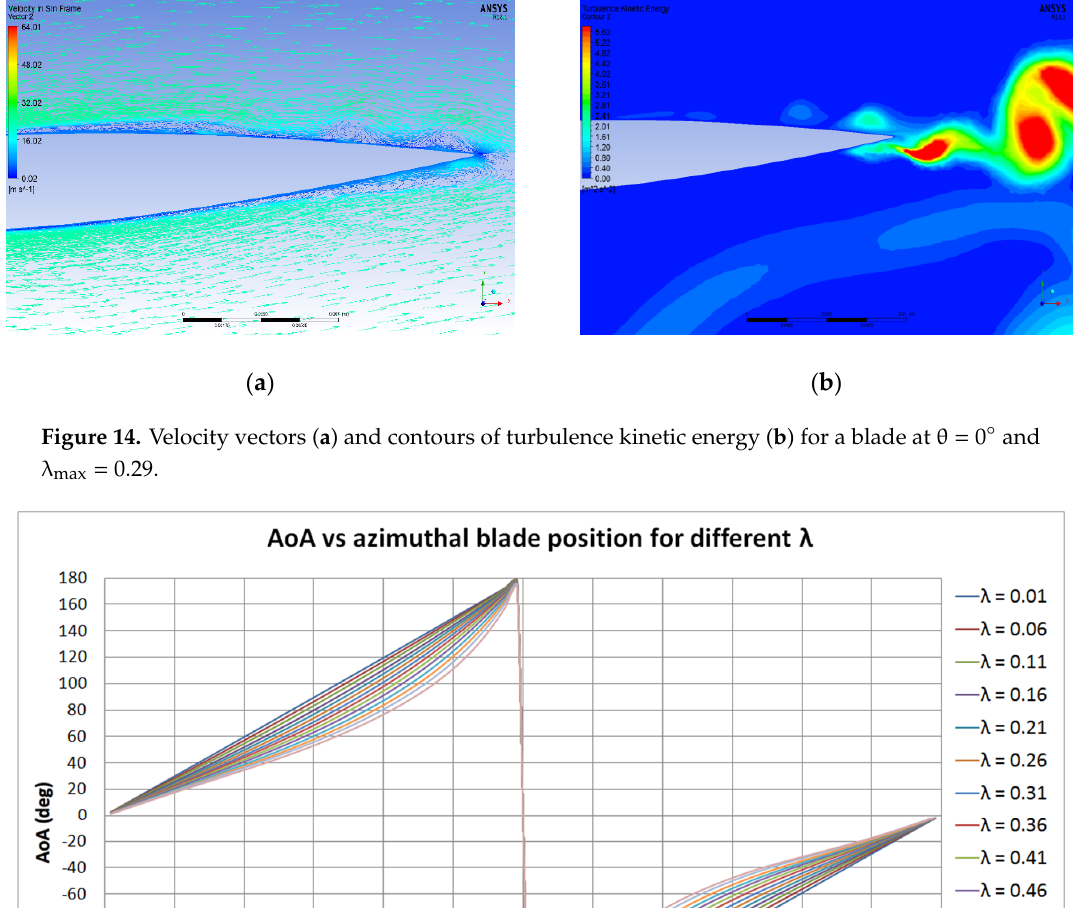
Figure 13. Contours of vorticity for DDES ( a ), RANS Transition ( b ) and RANS SST k-ω ( c ) at 45° azimuthal position at λ max = 0.29.